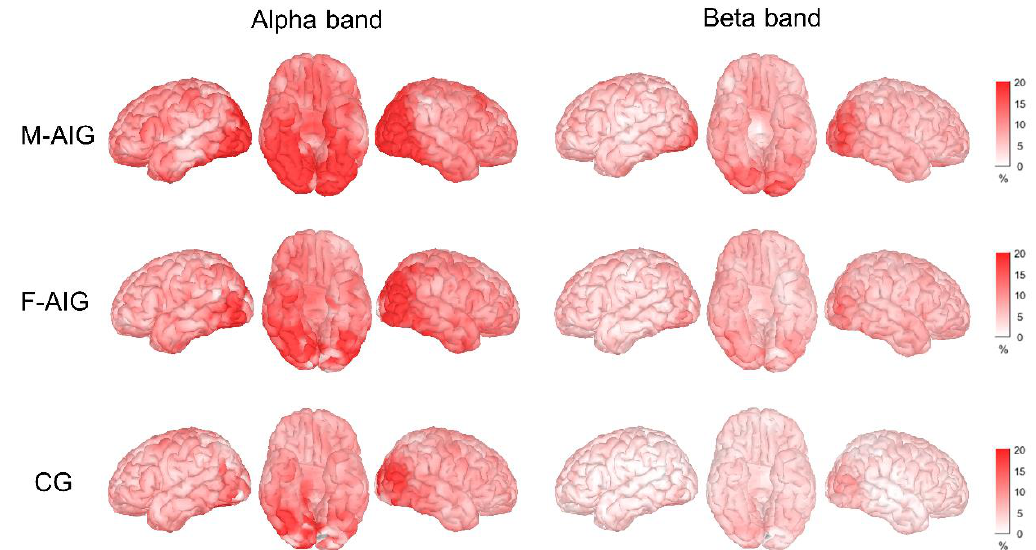
Figure 2. ERSPs map for the three groups in alpha and beta bands. The colors on the brain maps indicate ERS magnitudes (redder color indicates stronger ERS). M-AIG: male action observation- induced group; F-AIG: female action observation-induced group; CG: control group.